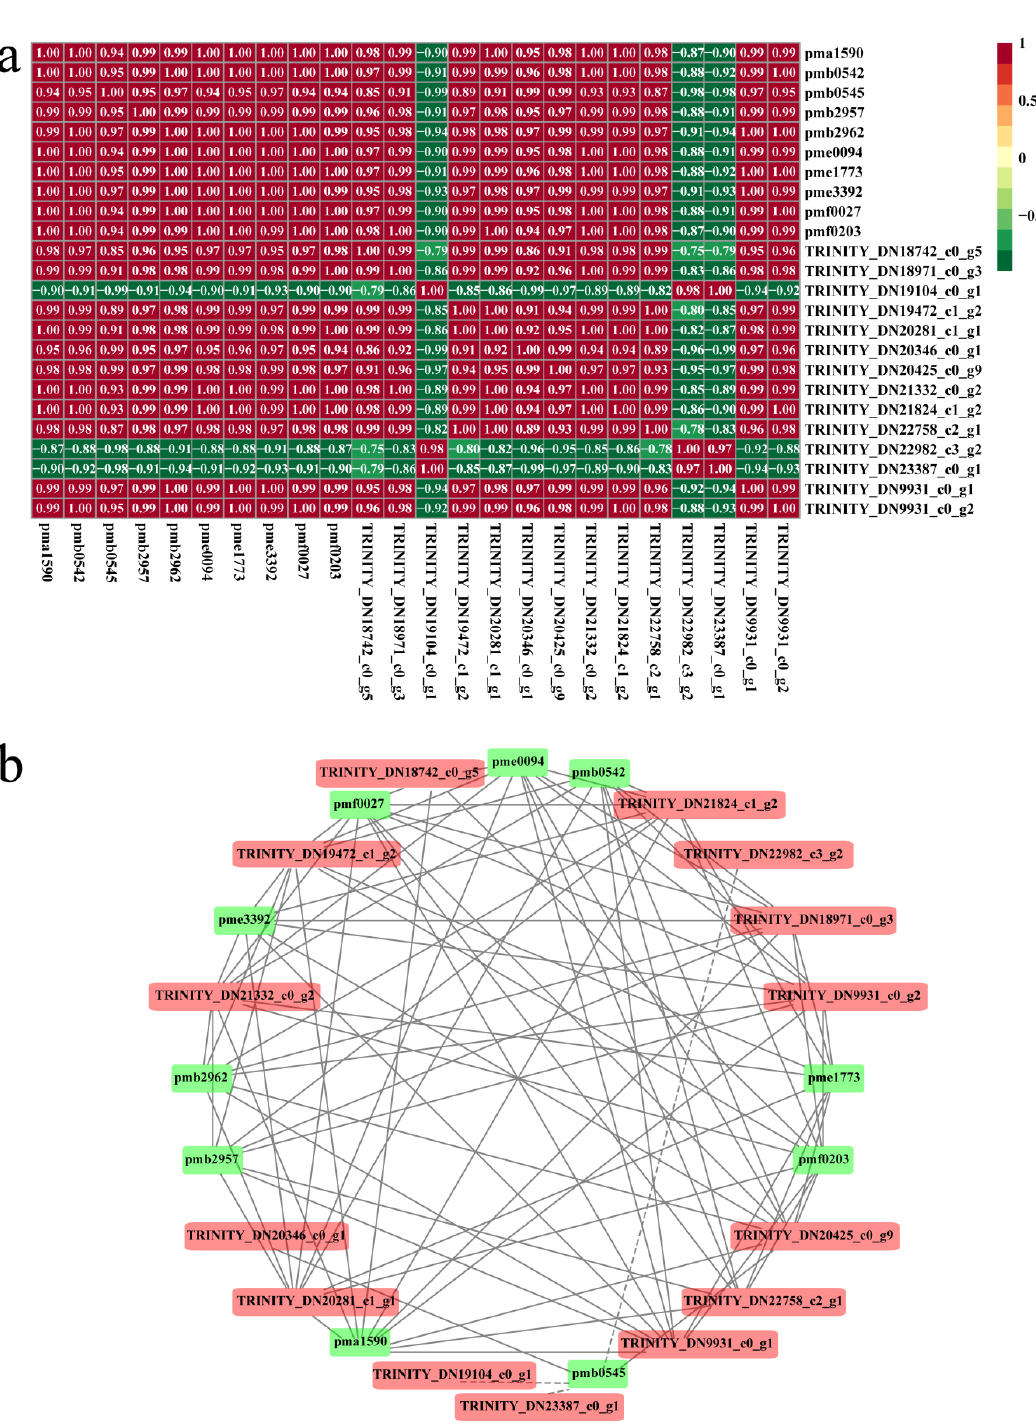
Figure 9. Correlation analysis of different metabolites and DEGs. ( a ): Red indicates a positive correlation, and green indicates a negative correlation. ( b ): Results of the correlation analysis between DEGs and metabolites. Positive correlations are indicated by a solid line, and negative correlations are indicated by a dotted line. Red indicates a metabolite, and green indicates a gene.